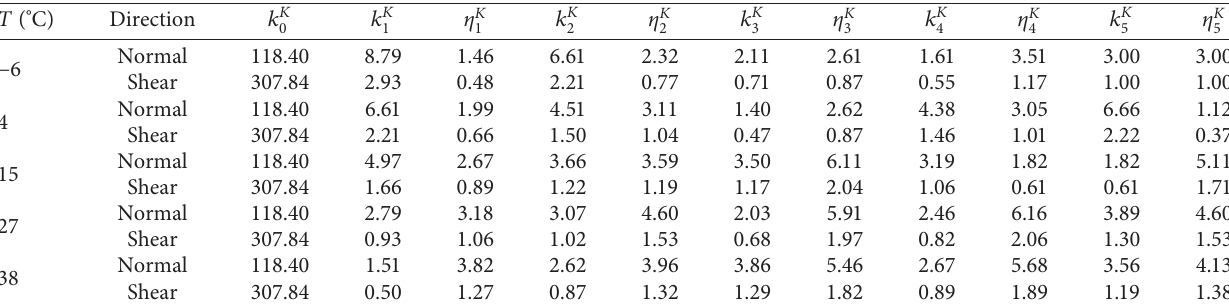
Table 4: Parameters of the numerical samples using the